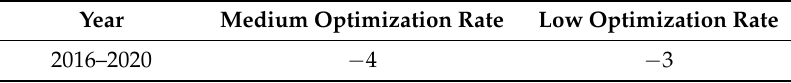
Table 8. Energy intensity enhancement rates of Beijing form 2016 to 2020 (%).